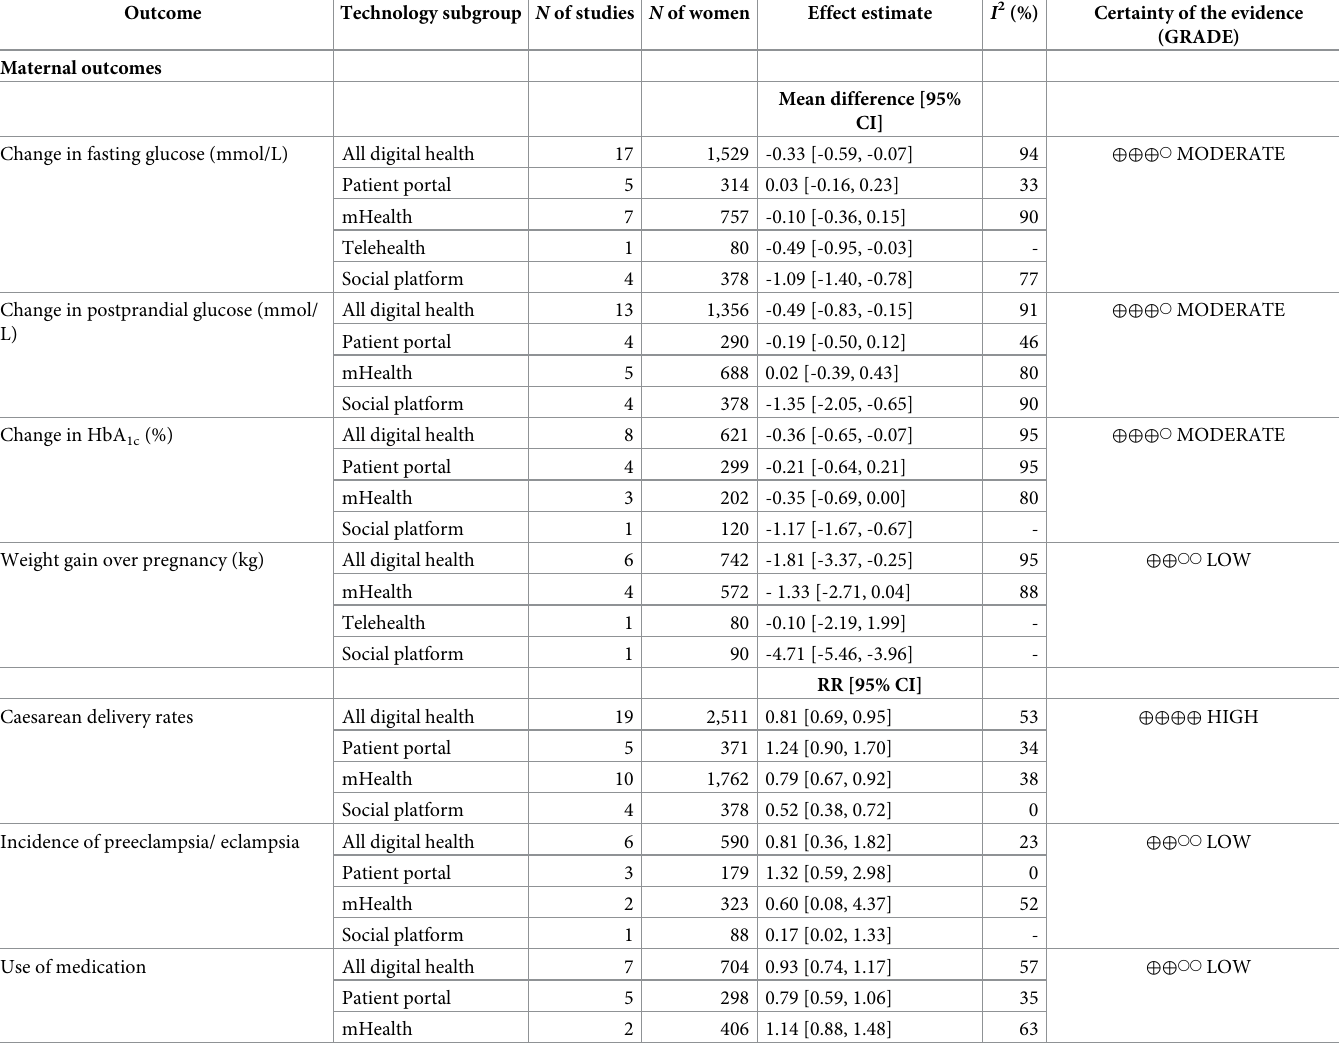
Table 3. Pooled analyses of maternal